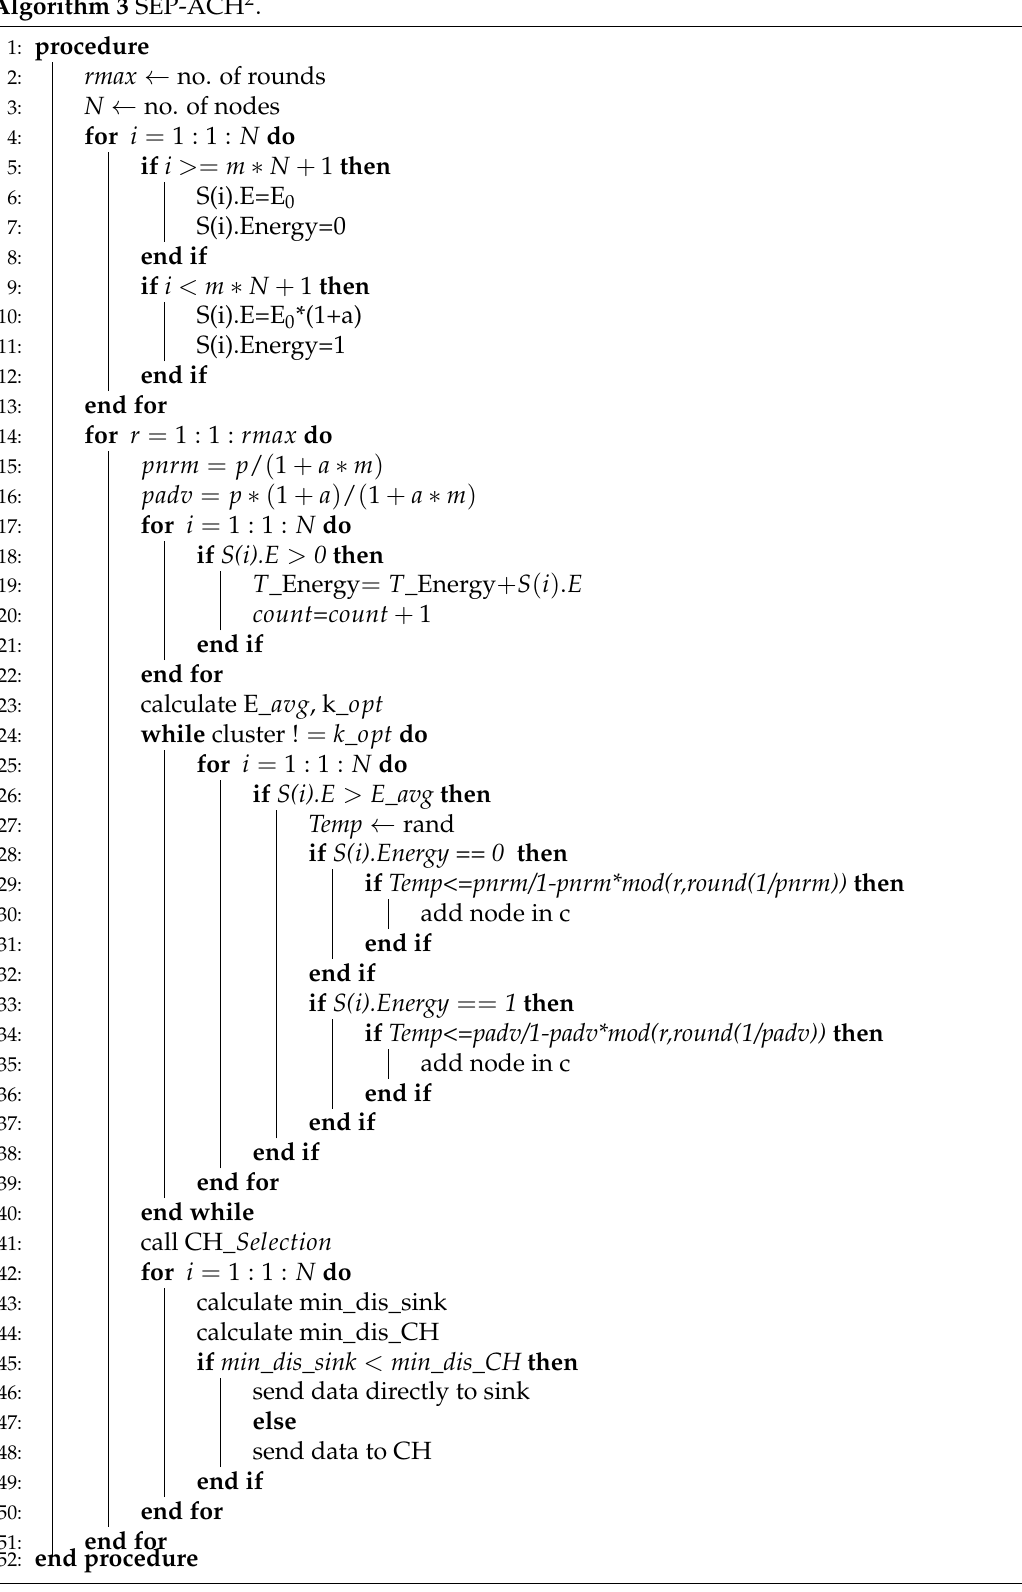
Algorithm 3 SEP-ACH 2